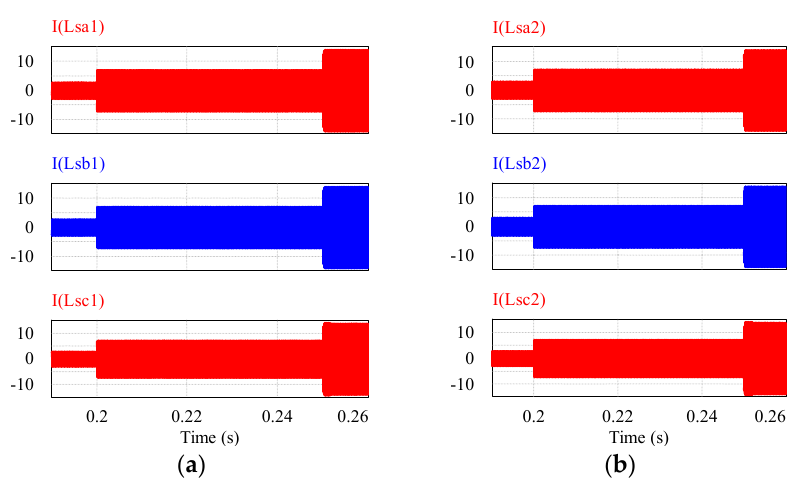
Figure 20. Simulation waveforms of resonant tank currents ( i Lsa , i Lsb , i Lsc ) in Phases A, B, and C with